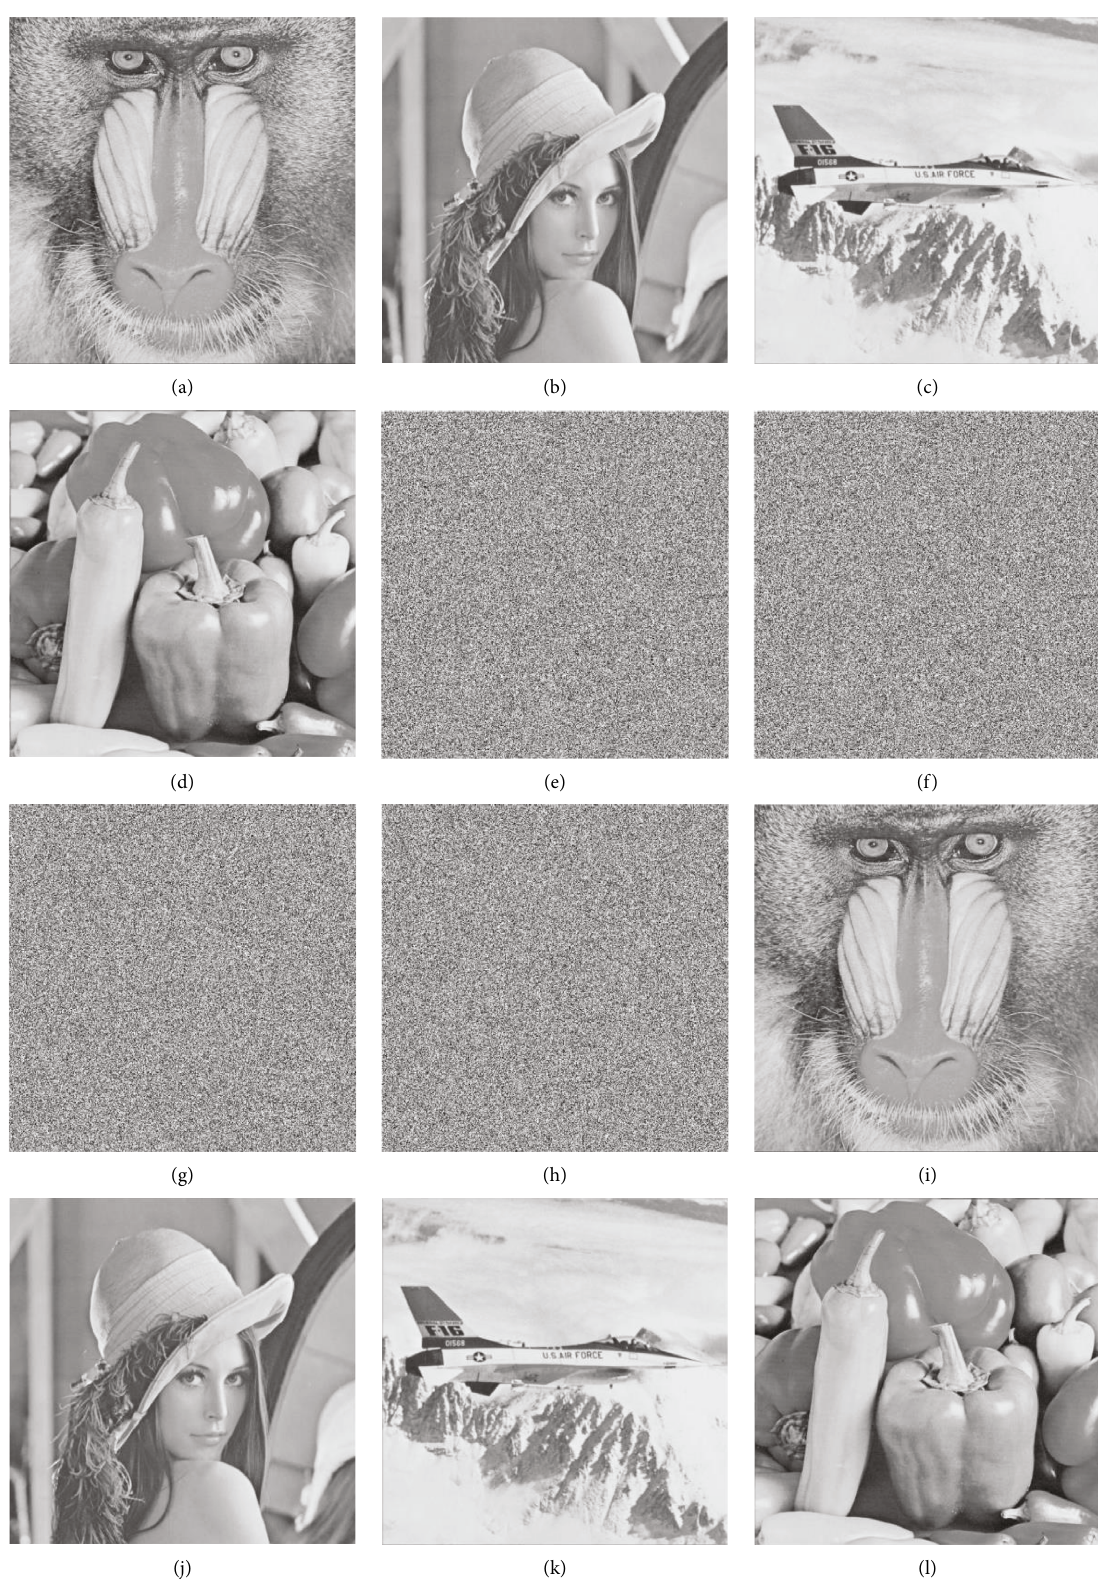
Figure 4: Simulation results: (a, b, c, d) plain images; (e, f, g, h) encrypted images; (i, j, k, l) decrypted